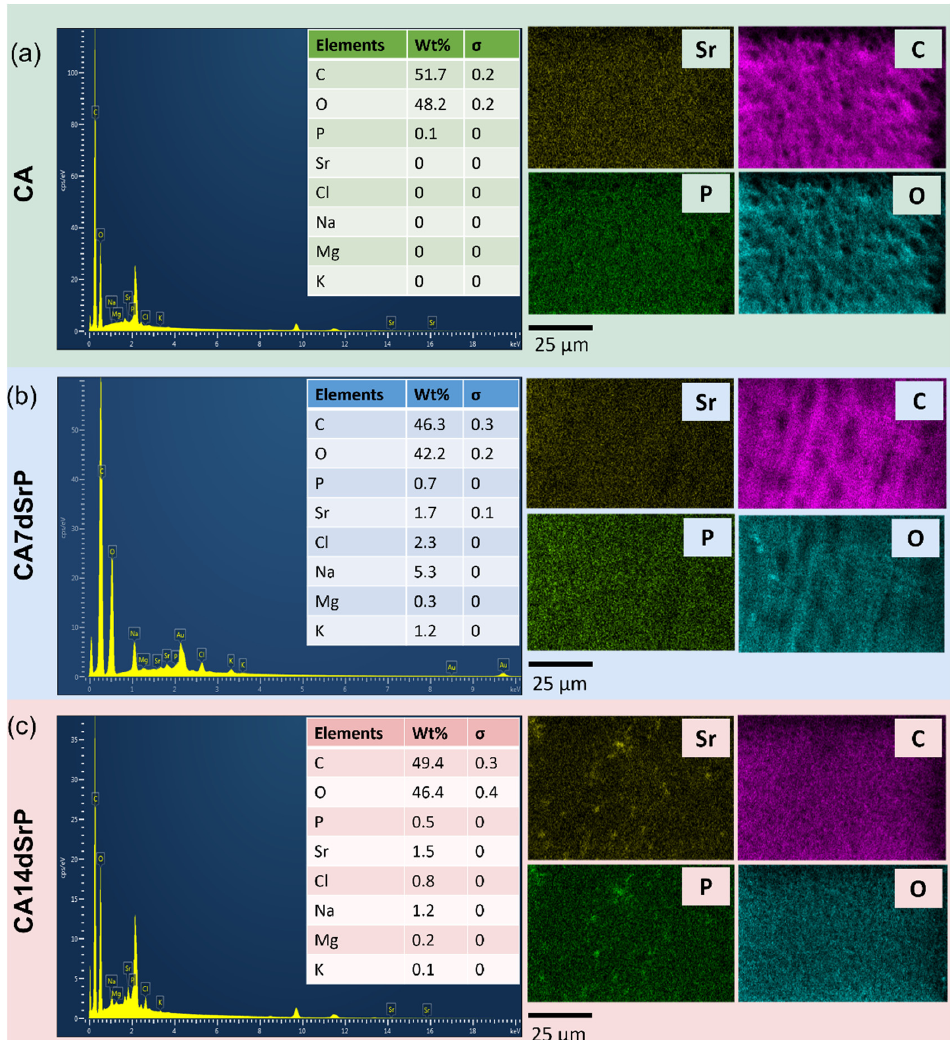
Figure 5. Scanning electron microscopy images of the surfaces and EDX maps (Sr, C, P, and O) of CA ( a ), CA7dSrP ( b ), and CA14dSrP ( c ).